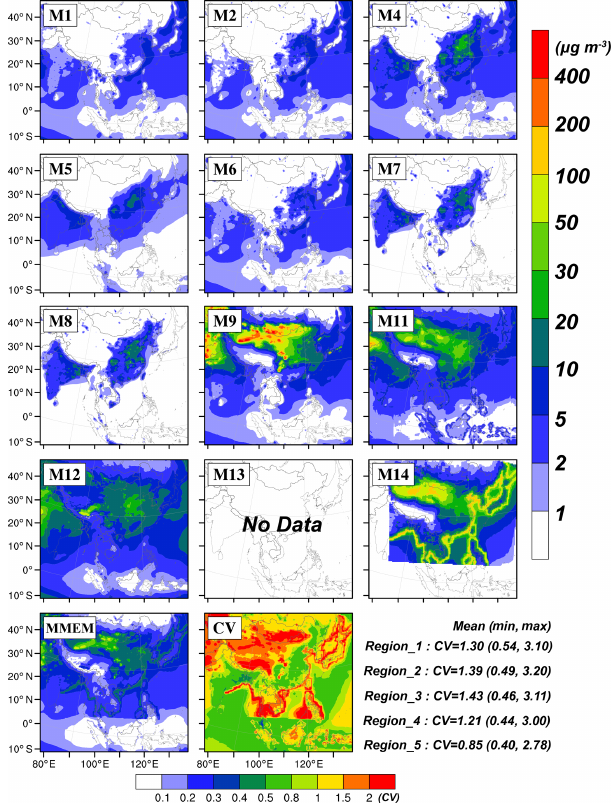
Figure 10. The same as Fig. 9 but for PM coarse (coarse particles, subtract PM 2 . 5 from PM 10